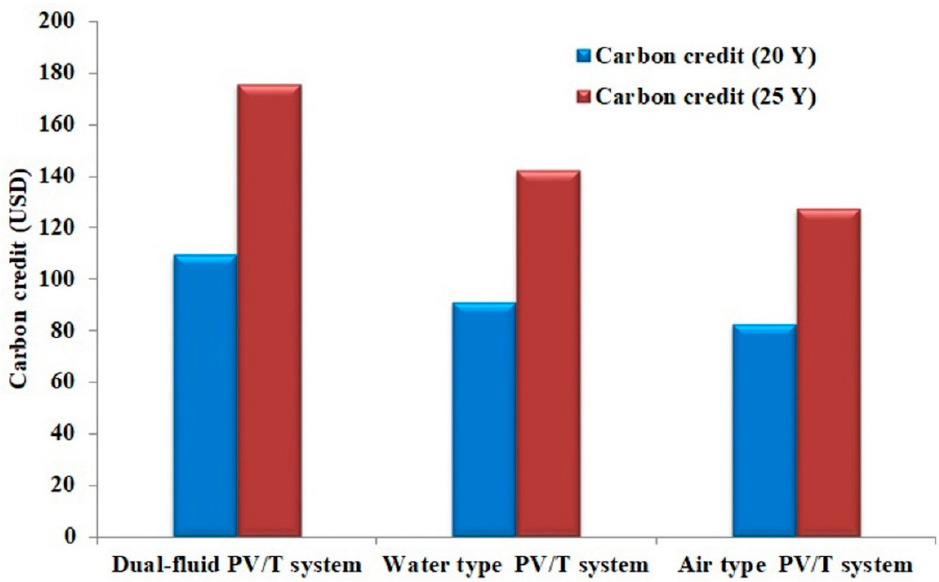
Figure 13. Carbon credits earned by different PV/T systems at 20 and 25 years.